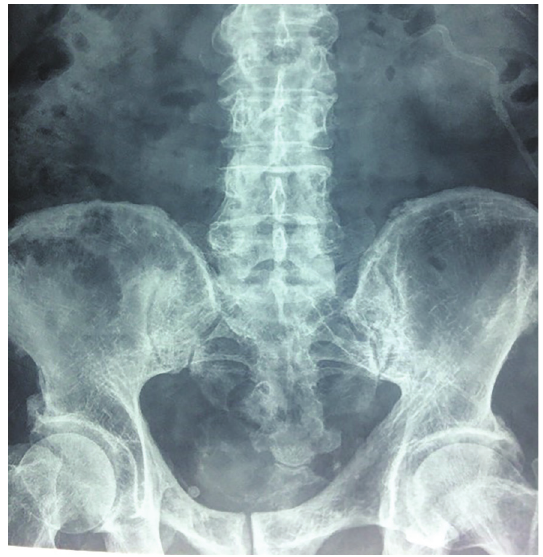
Figure 7 - Antegrade left